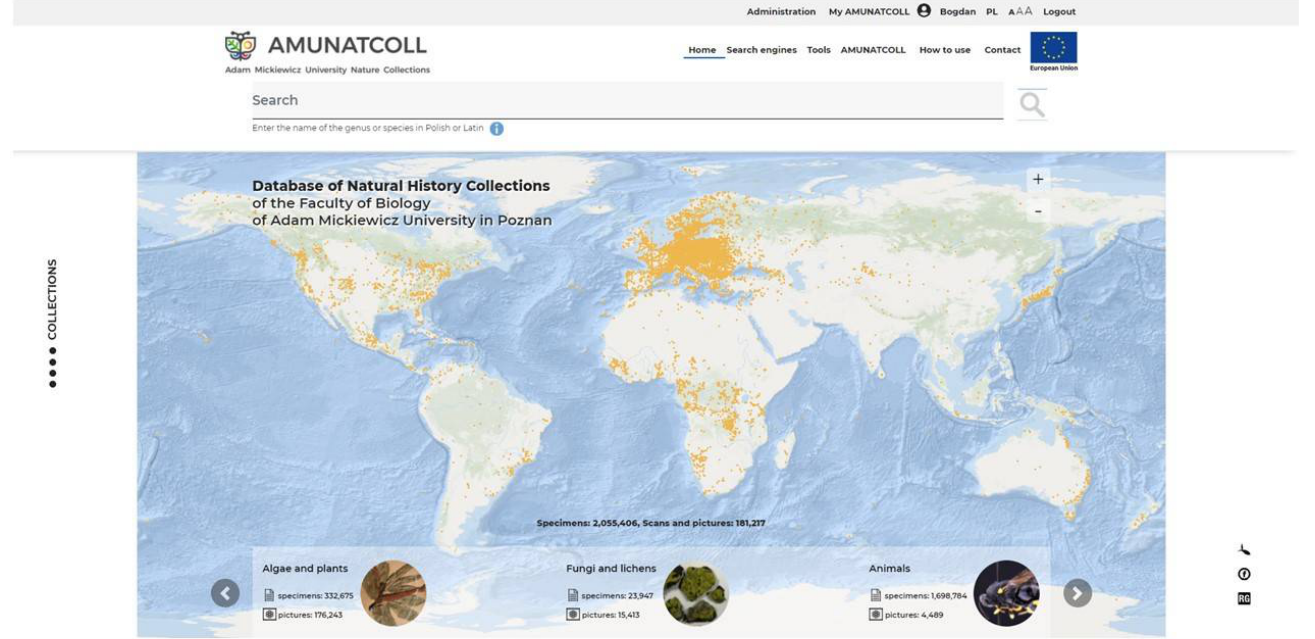
Figure 4. The homepage of the AMUNATCOLL portal https://amunatcoll.pl/ (accessed on 20 December 2021).